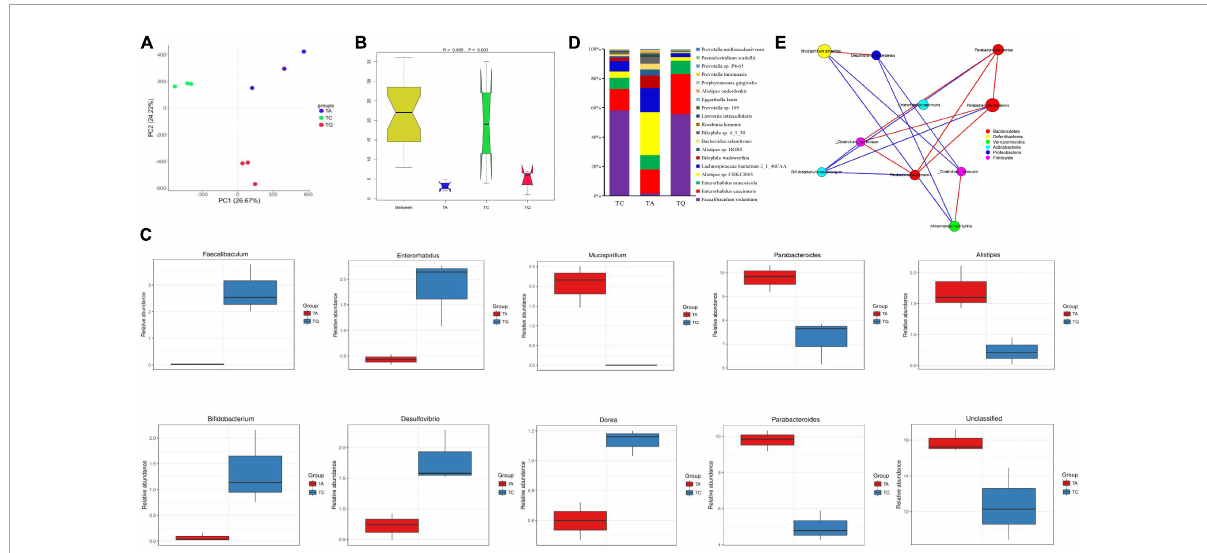
FIGURE2 Gut microbial diversity after quercetin treatment. (A) Principle coordinate analysis of gut microbial structure; (B) Anosim analysis of gut microbial structure within groups; (C) Top 5 Significantly different bacteria genera between groups; (D) Significantly different bacteria species between TA and TQ; (E) Spearman correlation analysis of bacteria species, which LDA score higher than 4, red line indicate positive correlation, blue line indicate negative